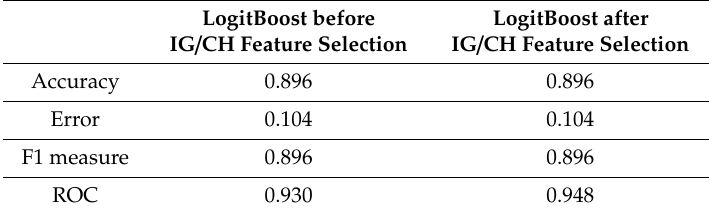
Table 9. Performance of LogitBoost before / after IG / CH feature selection using 10-cross validation.